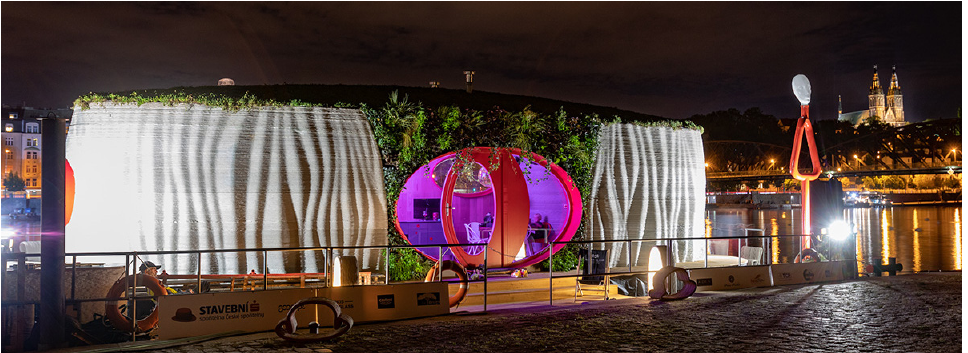
Figure 1. Prvok 1:1 3D printed structure.